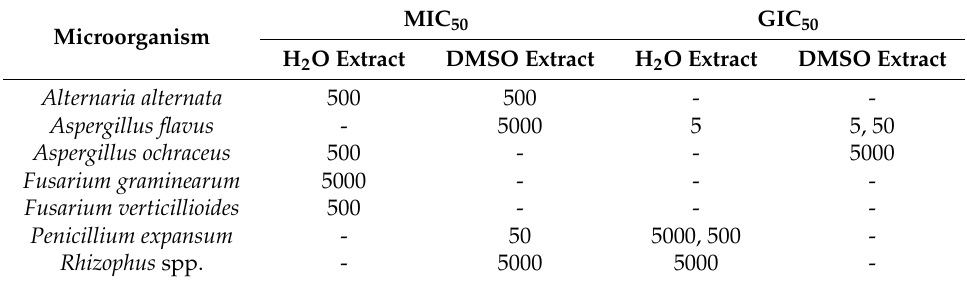
Table 3. Antifungal (MIC 50 ) and fungal growth inducing (GIC 50 ) effect of tested water (H 2 O) and dimethyl sulfoxide (DMSO) extracts of C. bursa on selected fungal